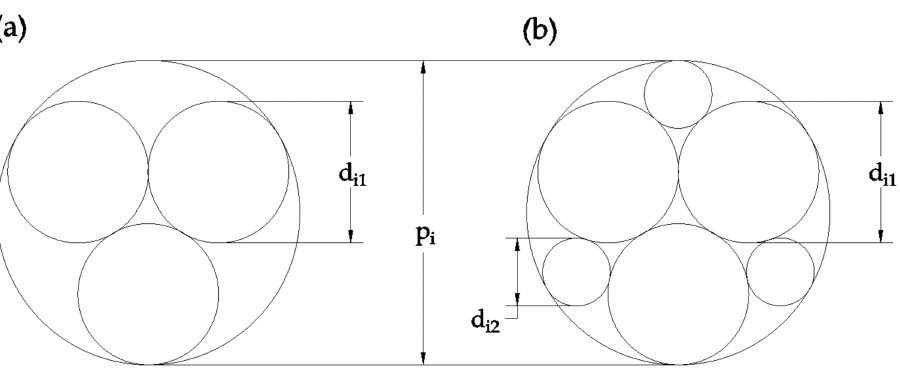
Figure 6. Representation of a partial Apollonian gasket created by filling the primary pore p i with: ( a ) three particles named d ij (j = 1), ( b ) six particles named d ij (with j ranging from 1 to 2 to distinguish particle size). In this figure ( a , b ) show two different degrees of filling possible in the proposed